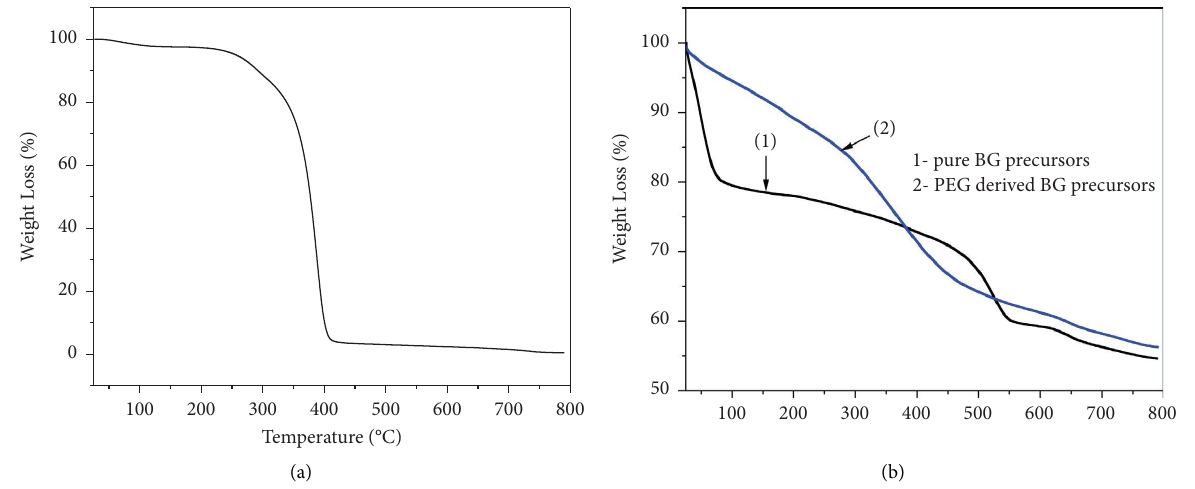
Figure 1: TGA data for (a) PEG and (b) pure BG and BG-derived PEG